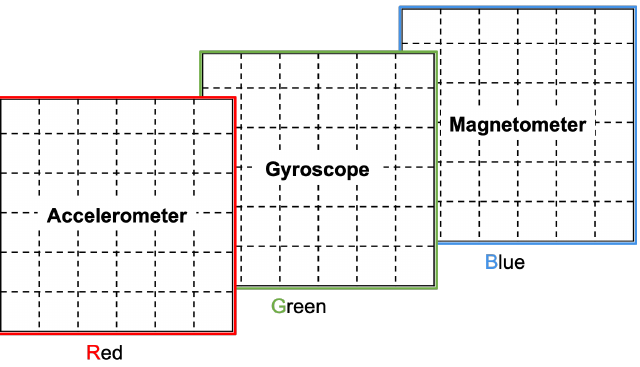
Figure 9. Simple color channel assignment to represent multiple